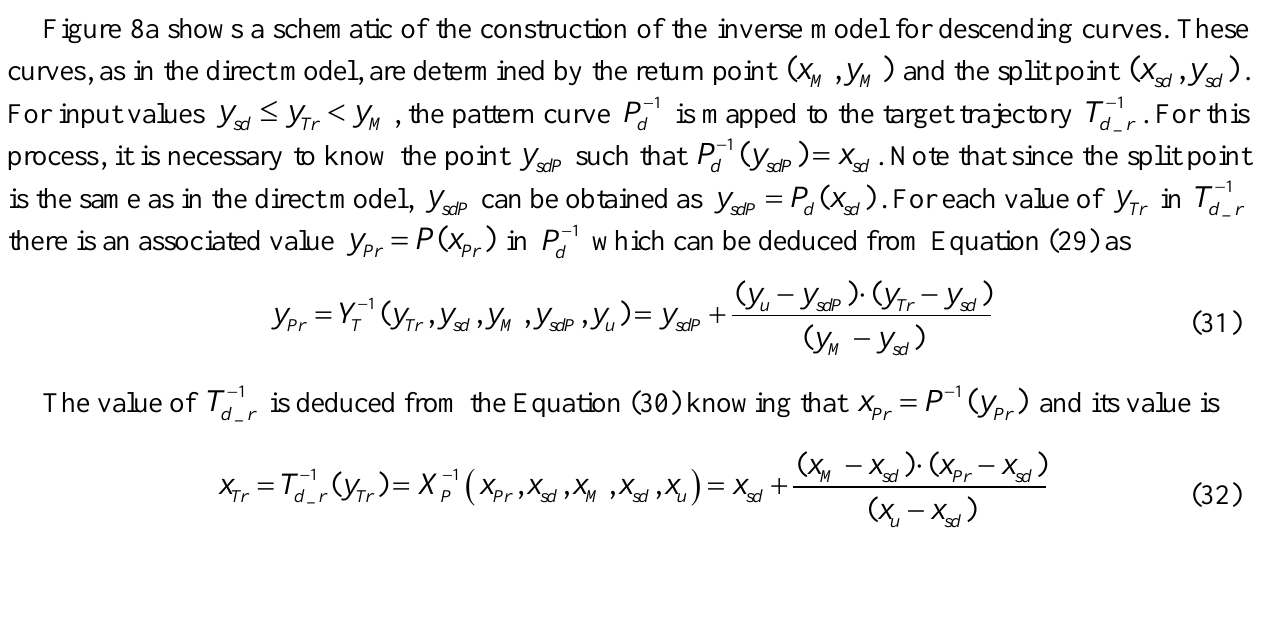
Figure 8. ( a ) Construction of descending curves for inverted ELAM. ( b ) Construction of ascending curves for inverted